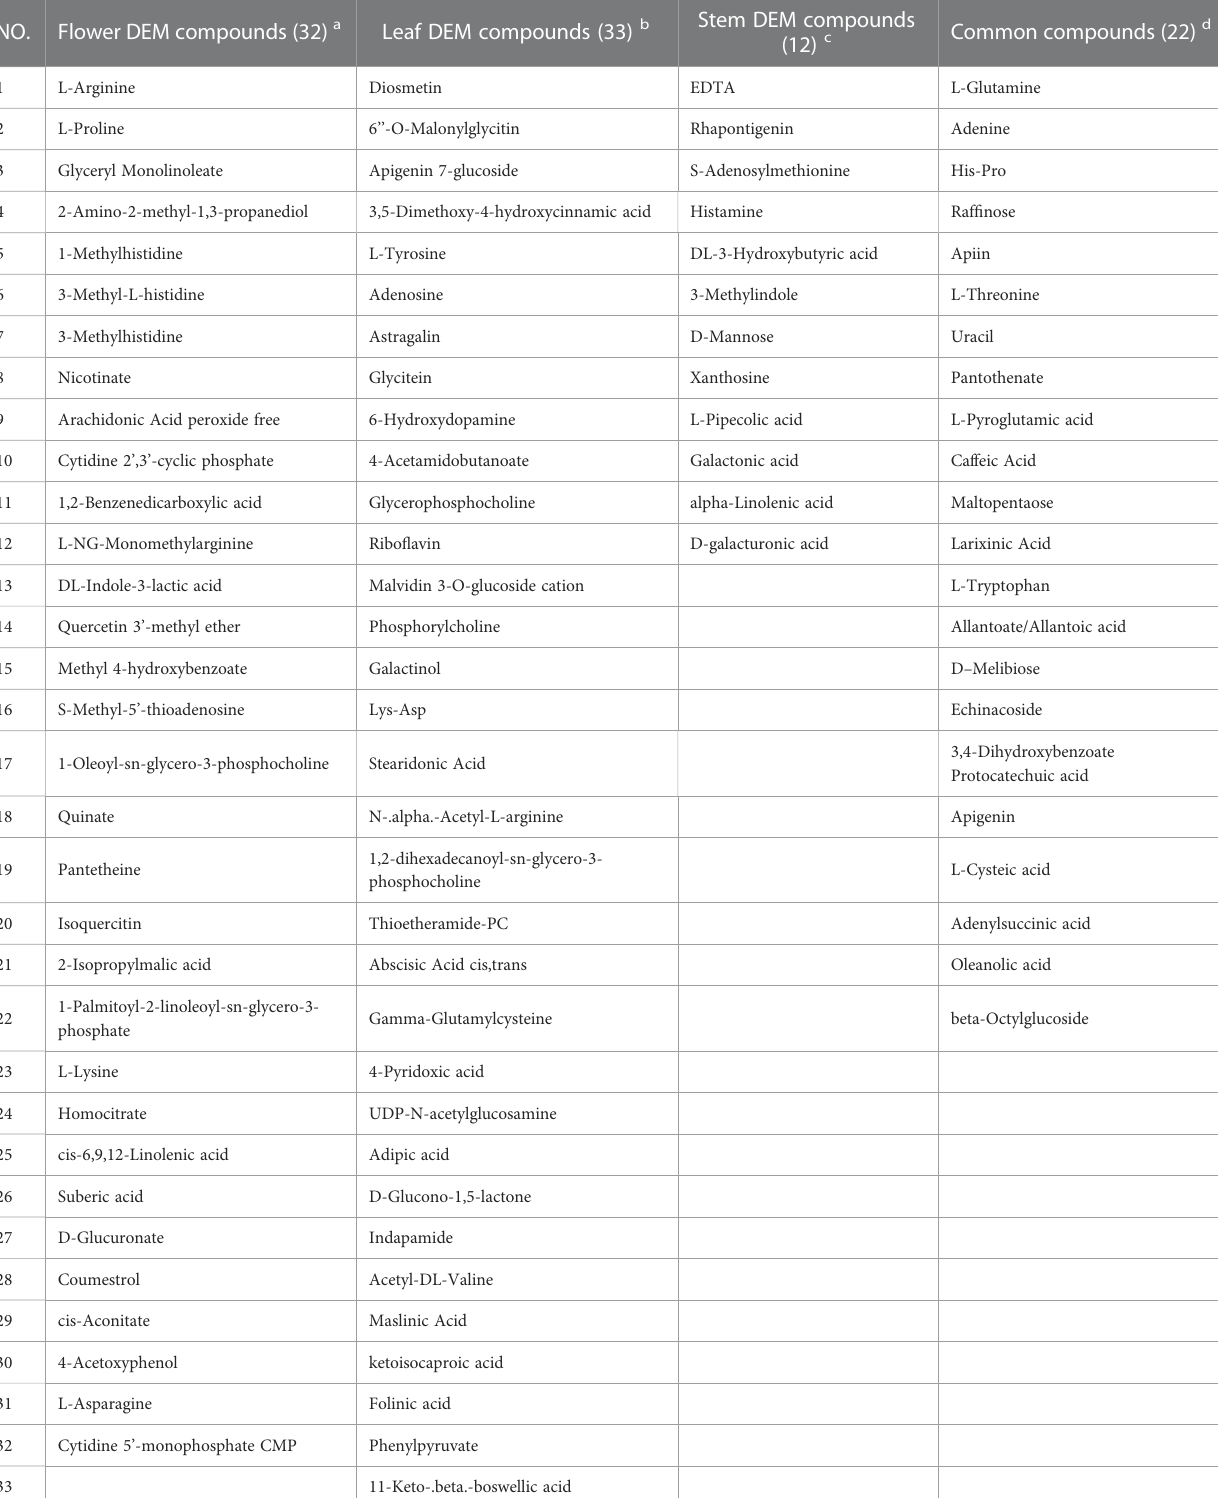
TABLE 1 The speci fi c and common metabolite compounds of different tissues detected by UHPLC-QTOFMS in P. cablin .